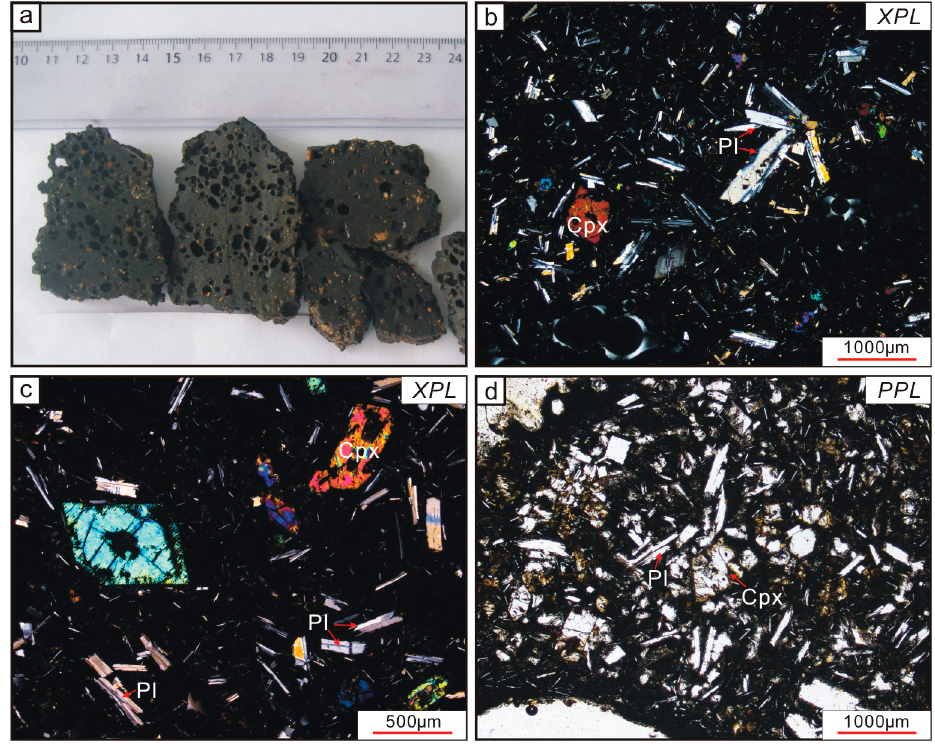
Figure 2. ( a ) Macroscopic photo of various rock specimens collected from the Nanyue seamount showing a pervasive isotropic, aphanitic fabric, a porous structure, and some amygdules. Photomicrographs of basalts from the Nanyue seamount showing: ( b ) porphyritic texture; ( c ) Clinopyroxene crystals with partially resorbed grain boundaries; and ( d ) Clinopyroxene crystals marginally converted to a mixture of clay minerals and oxyhydroxides. With one exception (photomicrograph d), all photomicrographs were taken under cross-polarized (transmitted) light (XPL). Photomicrograph d was taken under plane-polarized (transmitted) light (PPL). Abbreviations (in alphabetical order): Cpx—clinopyroxene; Pl—plagioclase.